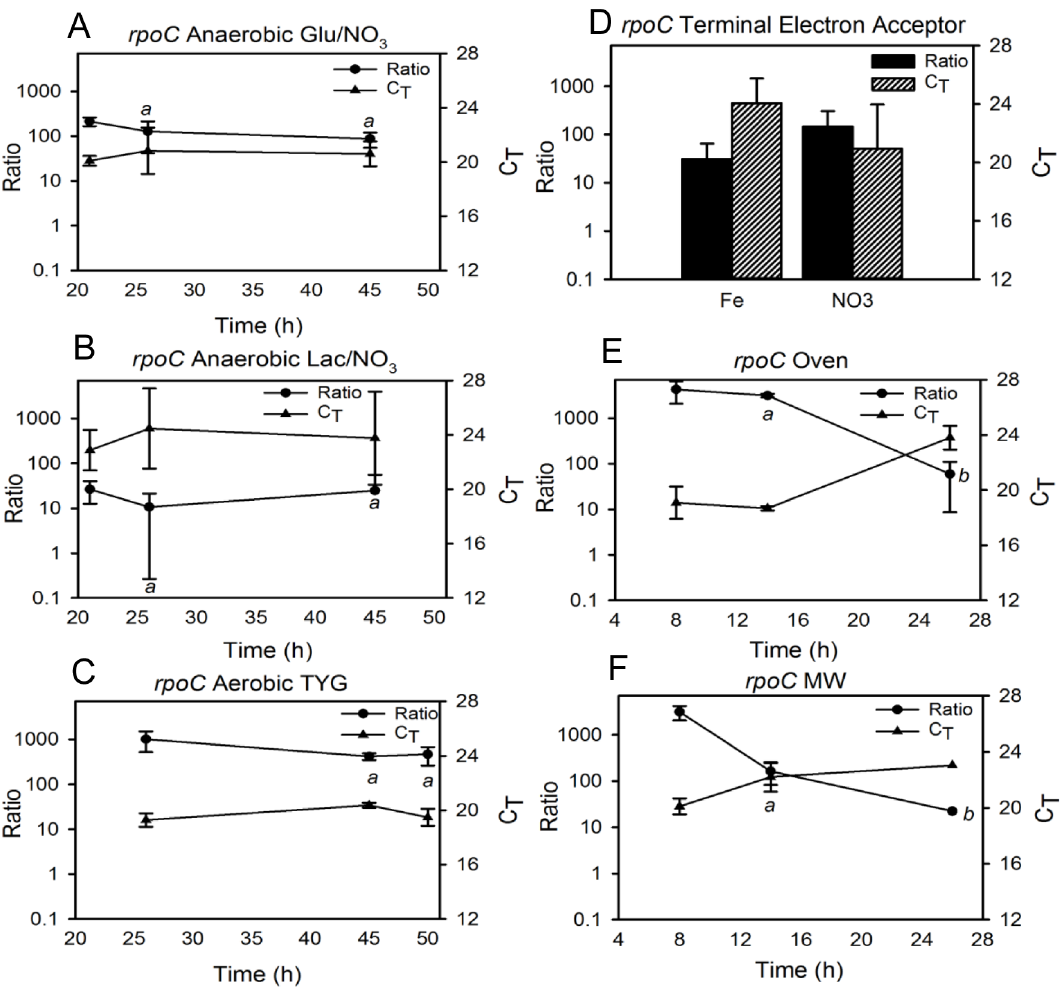
Fig 4. Correlation between rpoC transcript C T values and gene expression as derived from the transcript-to-gene copy number ratios. A standard curve was constructed and used to calculate the transcript copies per mL of sample and gene copies per mL of sample ( “ transcript-to-gene ratio ” ) under the different culture conditions described in the text. Ratio and C T values obtained for rpoC under: anaerobic growth with (A) glucose or (B) lactate as carbon source compared to (C) small-volume aerobic growth in TYG; (D) anaerobic growth with glucose as carbon source and nitrate or iron as terminal electron acceptor; and aerobic growth in TYG using (E) oven or (F) microwave heating. Glu = glucose, Lac = lactate, MW = microwave heating. a = indicates statistically significant difference (p < 0.05) among different culture conditions at specific time points; b = indicates statistically significant difference (p < 0.05) across time under one culture